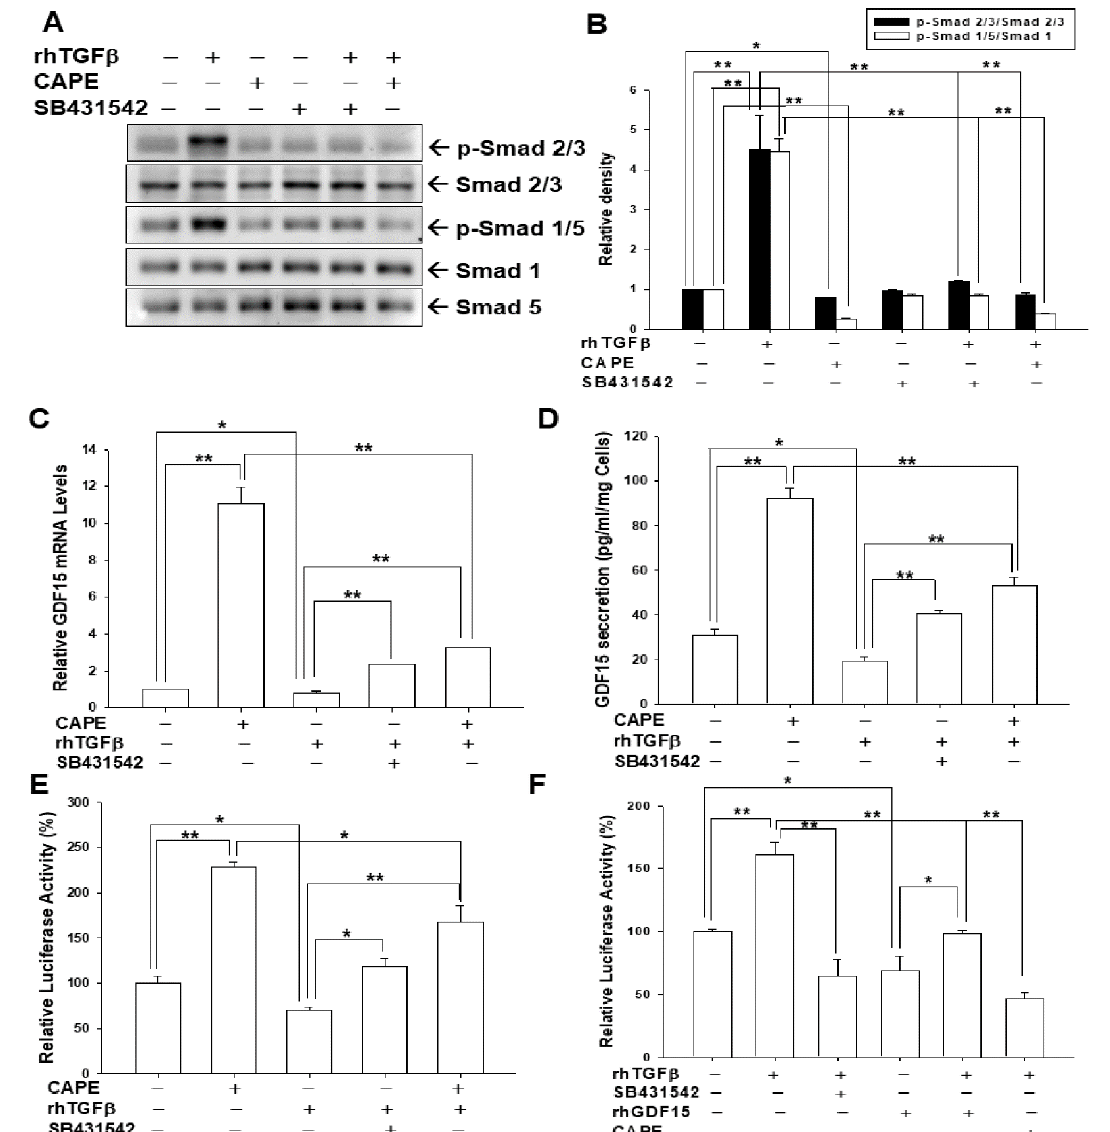
Figure 5. CAPE acts as the inhibitor of TGF β receptor kinase in human bladder carcinoma cells. ( A ) The Smad 2/3, p-Smad 2/3, Smad 1, Smad 5, and p-Smad 1/5 expressions were determined using immunoblot assays after one hour of 10 ng/mL TGF β treatments with (+) or without ( − ) 20 µ M CAPE or 20 µ M SB431542 pretreatment as indicated in T24 cells. ( B ) The quantitative data were expressed as the intensity bands of the phosphorylation proteins relative to the total protein levels for Smad 2/3 and Smad 1 (mean ± S.E.; n = 3). HT1376 cells were treated with 10 ng/mL rhTGF β treatments with (+) or without ( − ) 20 µ M CAPE or 20 µ M SB431542 pretreatment as indicated for 18 h. ( C ) The relative mRNA levels ( n = 3) of GDF15 were determined by RT-qPCR assays and ( D ) the supernatants of culture media ( n = 4) were collected and GDF15 secretions were determined by ELISA. ( E ) The reporter activity of the GDF15 reporter vector treated with (+) or without ( − ) 10 ng/mL rhTGF β , 20 µ M CAPE or 20 µ M SB431542, as indicated, in the HT1376 cells. ( F ) The reporter activity of the SEB4 reporter vector treated with 10 ng/mL rhTGF β treatments with (+) or without ( − ) 20 µ M CAPE or, 20 µ M SB431542, or rhGDF15 pretreatment as indicated, in the HT1376 cells. Data are expressed as the mean percentage of luciferase activity relative to the mock-treated group ( n = 6). * p < 0.05, ** p <